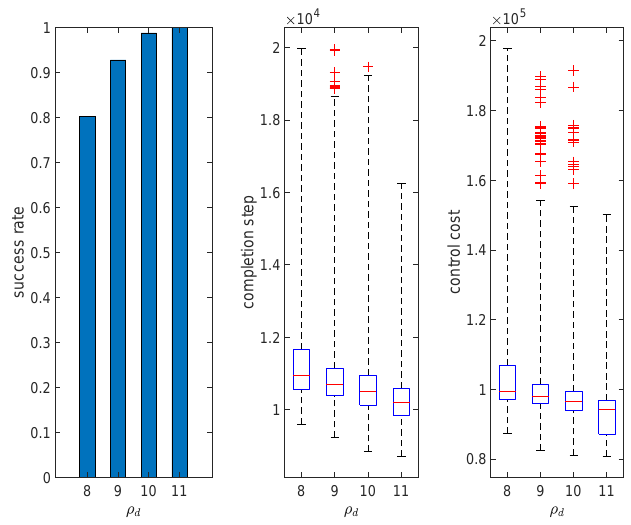
Figure 13. The influence of the size of the destination area on Algorithm 3.